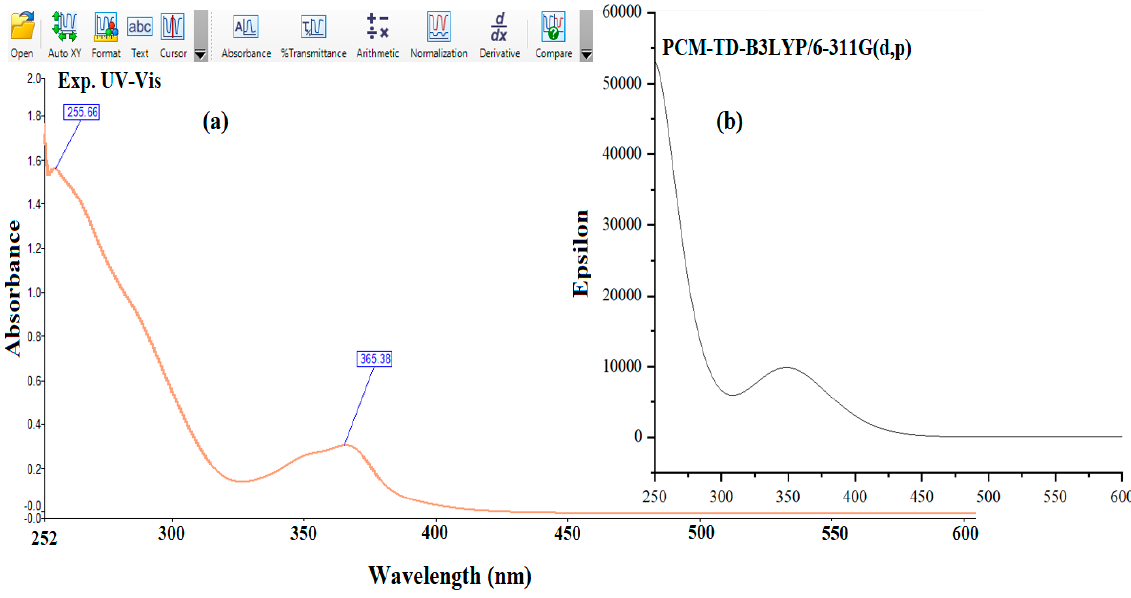
Figure 8. Experimental ( a ) and calculated ( b ) UV − vis absorption spectra of the 3-O-methyl ellagic acid dihydrate. Table 3. UV/Vis spectral characteristic of compounds 1 and 2 in the solution